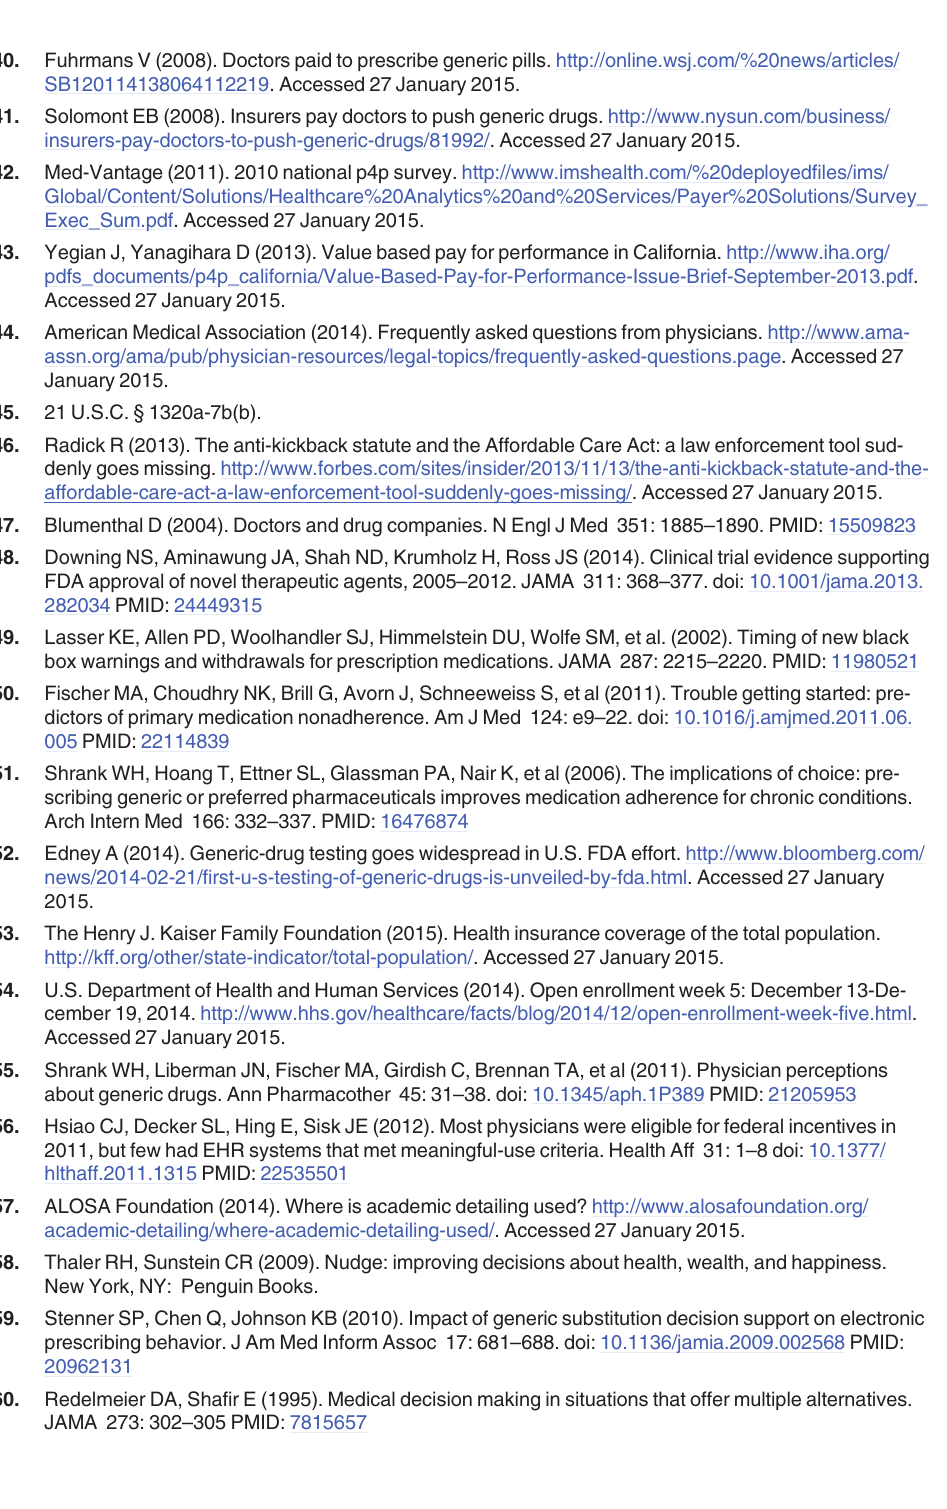
PLOS Medicine | DOI:10.1371/journal.pmed.1001802 March 17,